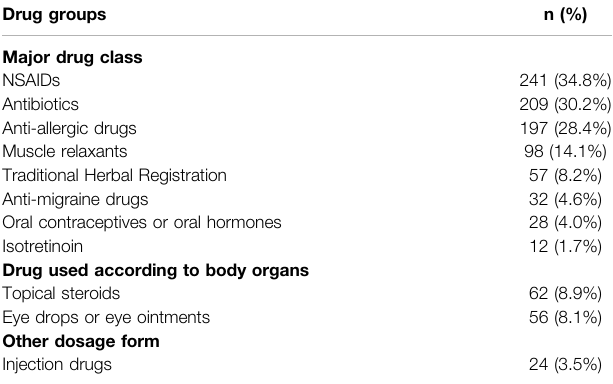
TABLE 2 | Drug groups used for self-medication ( n (cid:1) 693). Drug groups n